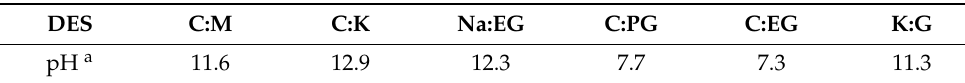
Table 2. pH value of